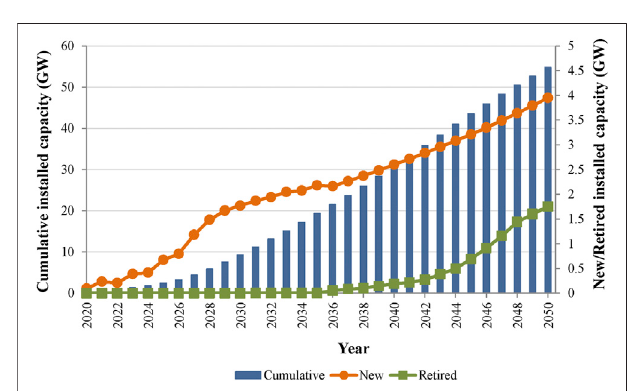
FIGURE 5 | Optimization path of CSP development in the base